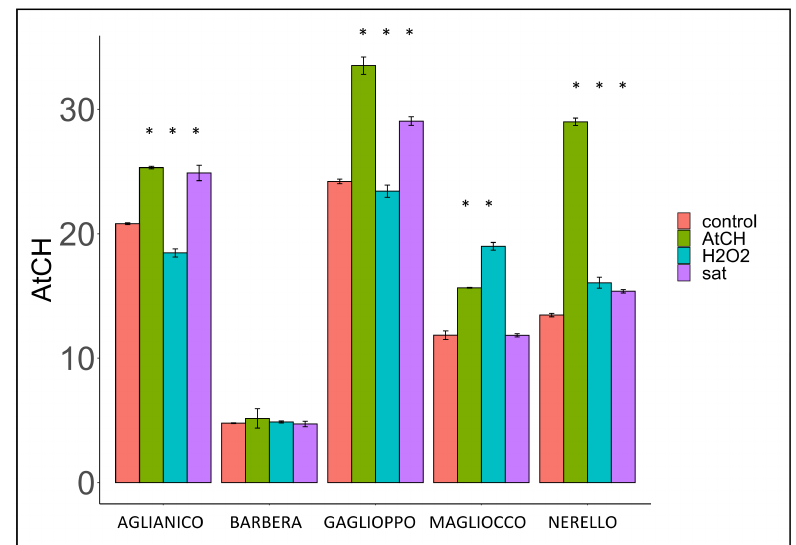
Figure A3. Acetaldehyde content in wines before and after oxidative treatments. Asterisks (*) indicate significant differences between treated wine and its control ( p -value less than